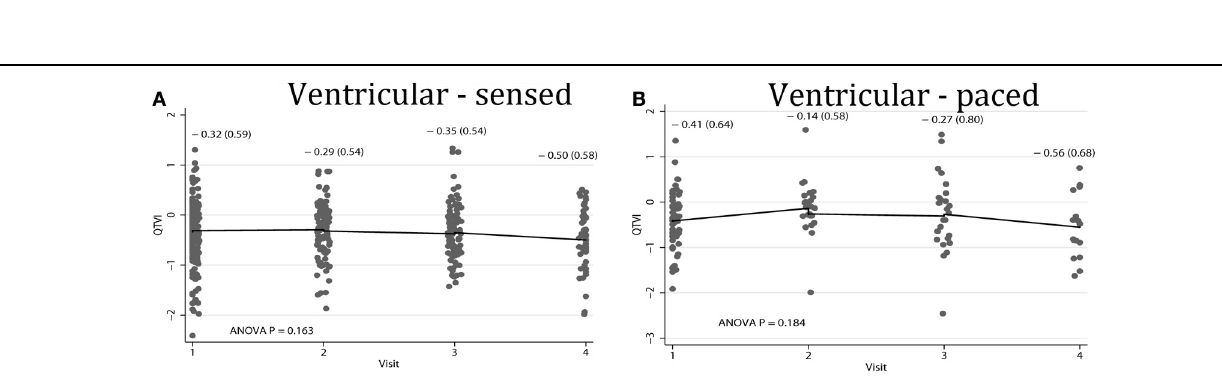
FIGURE 2 | Comparison of population-averaged longitudinal trends in QTVI NF in patients with (A) single-chamber ICD, (B) dual-chamber ICD, (C) CRT-D. Scatterplot of QTVI NF at each standardized study visit is shown. Lowess smoother curve shows mean trend in QTVI NF over time.